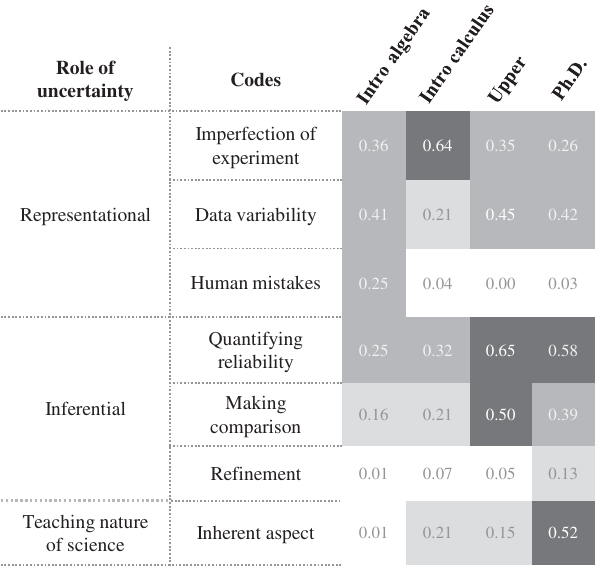
FIG. 3. Fraction of student responses with a particular code in the subpopulation (e.g., intro algebra-based physics). Students ’ responses may be coded under several codes when appropriate so fractions do not add up to 1.00. Five levels of gray scale shading were applied based on the fraction, f (from lightest to darkest): f < 10% (white); 10% ≤ f < 25% ; 25% ≤ f < 50% ; 50% ≤ f < 75% ; f ≥ 75%